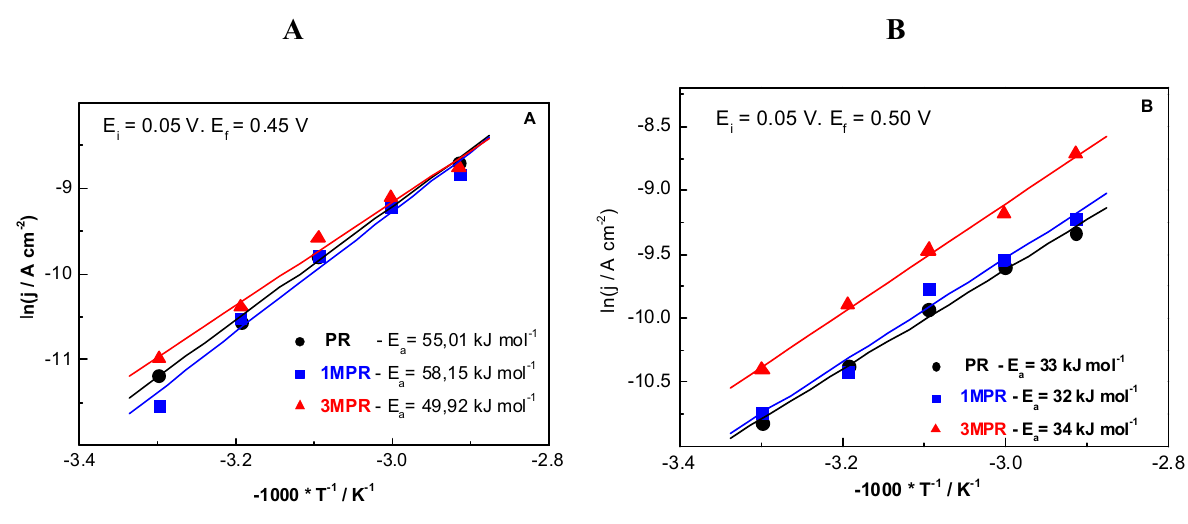
Figure 14. Arrhenius plot and activation energies at 0.45 V for methanol oxidation ( A ) and at 0.5 V for ethanol oxidation ( B ) vs. RHE for PR, 1MPR and 3MPR catalysts. Reprinted with permission from Int. J. Hydrogen Energy 2012, 37 , 7131 [47]. Copyright 2012.